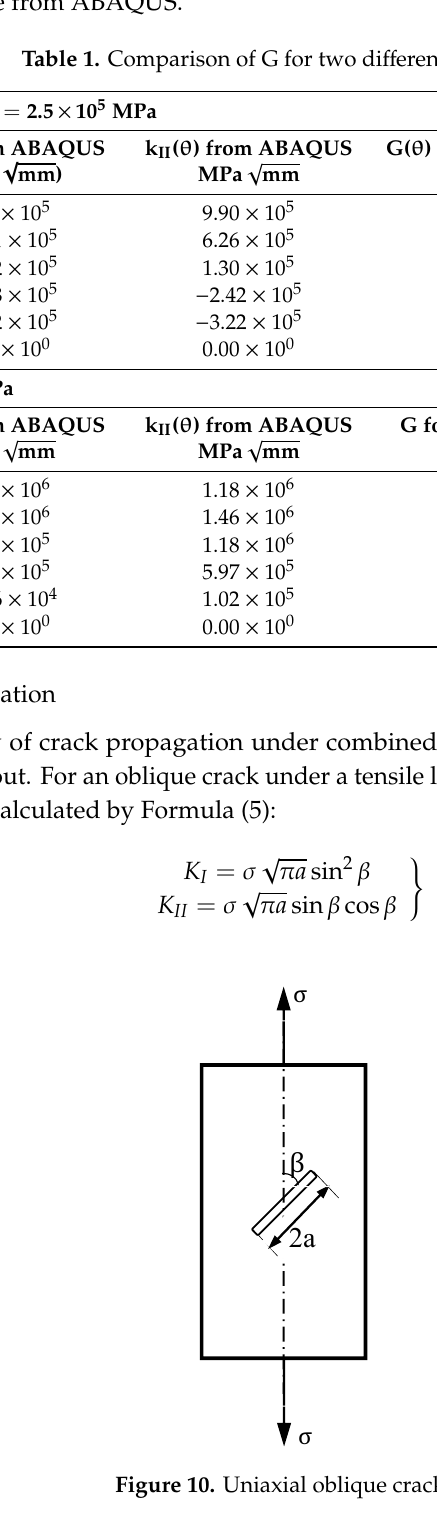
Table 1. Comparison of G for two different methods.